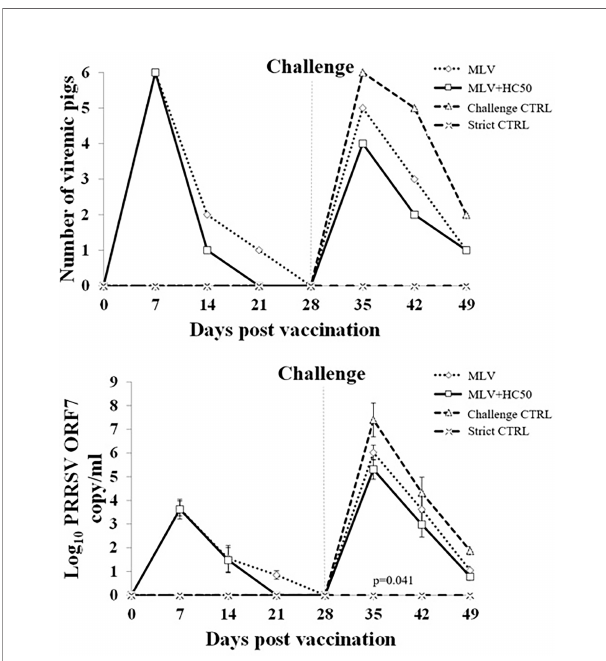
FIGURE 8 | Number of viremic pigs and log 10 PRRSV ORF7 copy numbers in serum following the HP-PRRSV-2 challenge. Pigs ( n = 6) were injected i.m. with Amervac ® PRRS MLV (0 dpv) (MLV) and Amervac ® PRRS MLV (0 dpv) and fed p.o. with HC50 (0 – 49 dpv) (MLV+HC50) or vaccine solvent used for resuspension of lyophilized Amervac ® PRRS MLV (0 dpv) (Challenge CTRL). The animals were challenged i.n. with HP-PRRSV at 28 dpv (0 dpc) (dotted vertical line). Strict control pigs (Strict CTRL) received no treatment. Serum samples were collected weekly from all pigs at 0 – 21 dpc and were determined for PRRSV ORF7 copy numbers by real-time PCR. The C T obtained from each sample was compared with the C T standard curve generated from 10 1 to 10